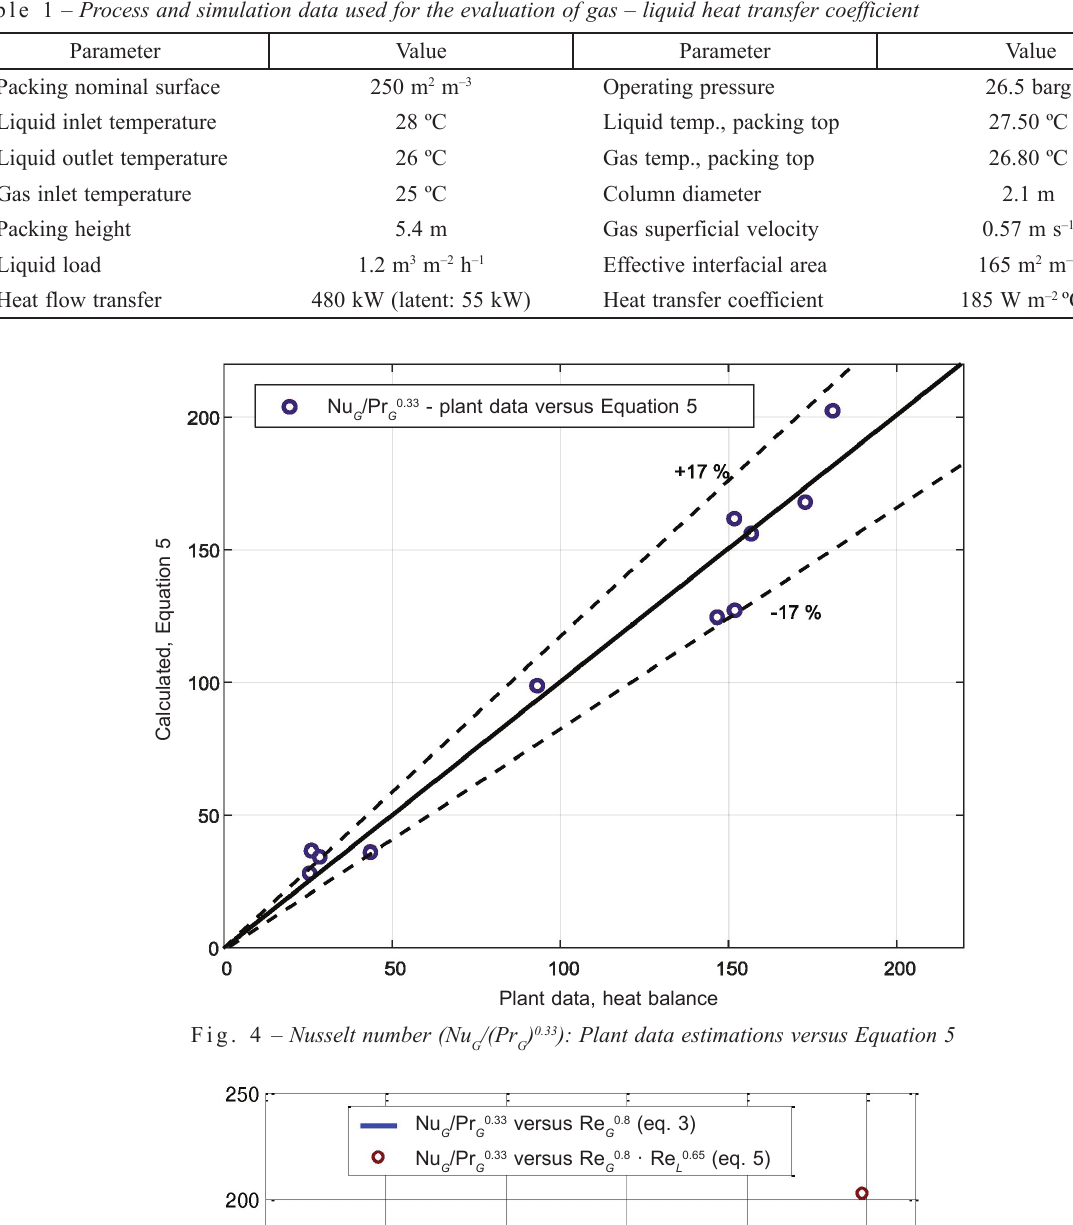
/(Pr ) 0.33 ): Plant data estimations versus Equation 5 G G